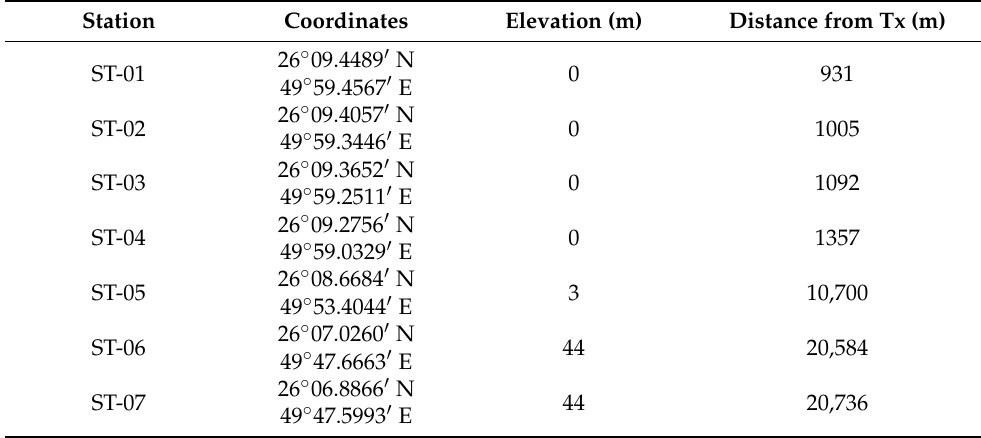
Table 1. The locations of the MT/CSEM receivers’ coordinates are presented.